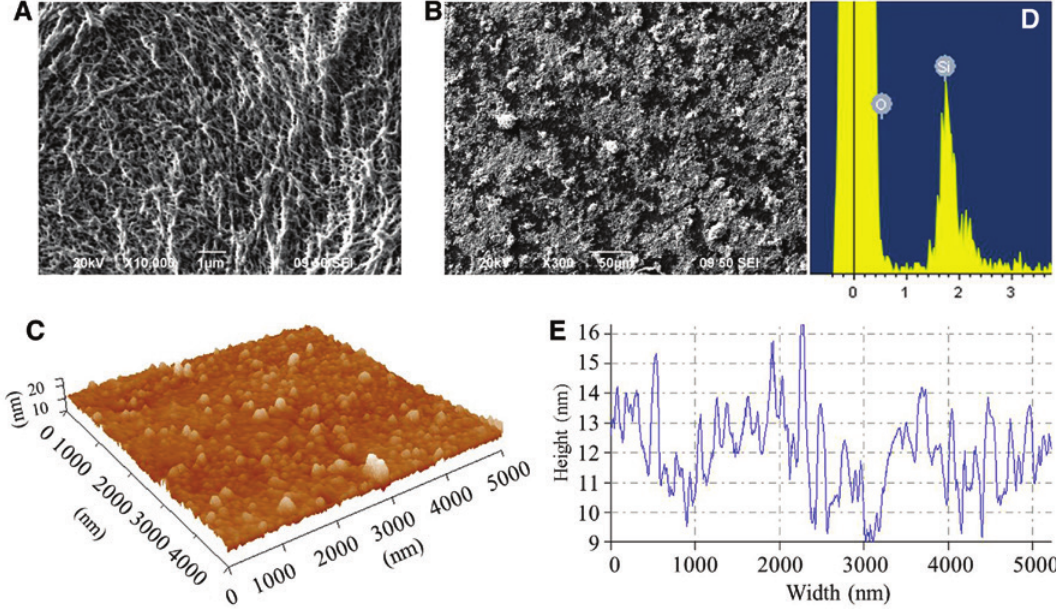
composite membrane and EDX observation of Si element on PE membrane and AFM 2